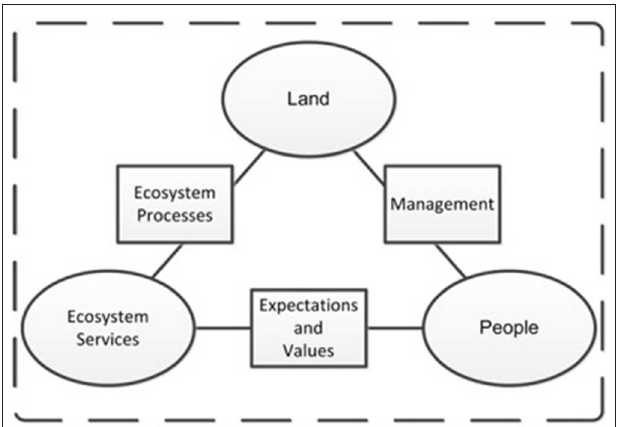
FIGURE 2 | Framework for discussions regarding ecosystem services, with six major themes developed through a Delphi survey of stakeholders working on agricultural sustainability in central Iowa. The bounding box, though dashed to recognize connections to other regions and systems, represents the need to bound discourse in time and space for effective communication among